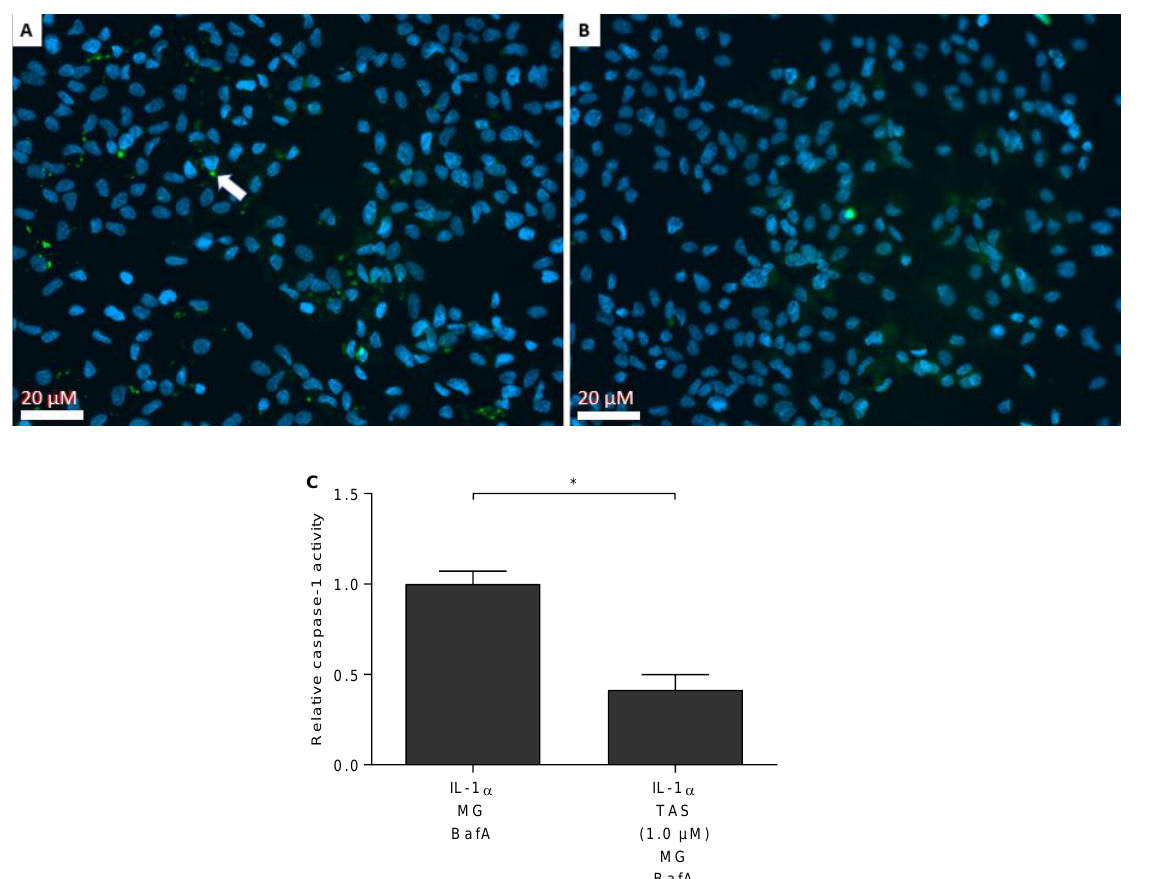
Figure 5. The measurement of caspase-1 activation using the FLICA assay. Nuclei were stained with Hoechst33342 (blue) and active caspase-1 with FLICA probe (green, white arrow) in IL-1 α -primed RPE cells treated with MG-132 (MG) + Bafilomycin A1 (BafA; A ), or with MG + BafA + TAS-116 (TAS; 1.0 µ M; B ). The amount of activated caspase-1 was compared to the number of nuclei and thereafter normalised to the IL-1 α + MG + and BafA group ( C ). Images were taken at 20 × magnification with one image per sample being shown. The data of the bar plot are combined from two individual experiments with two parallel samples per group and are presented as mean ± SEM. * p < 0.05, Mann–Whitney U test.